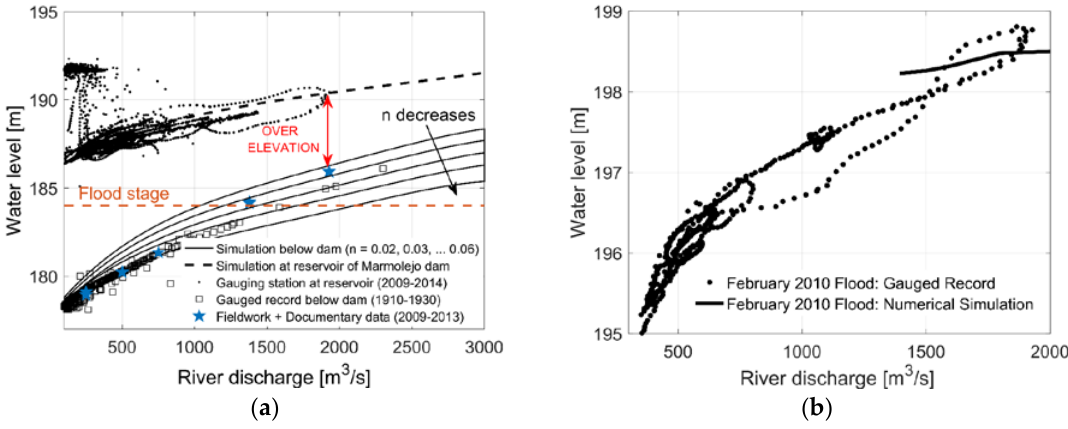
Figure 8. Measured and simulated rating curves at stream gauges: ( a ) reservoir and foot of Marmolejo dam; and ( b ) Roman Bridge of Andújar city. Panel ( a ) includes a sensitivity study of the dam; and ( b ) Roman Bridge of And ú jar city. Panel ( a ) includes a sensitivity study of the model results model results downstream of Marmolejo dam with variations in the Manning’s roughness downstream of Marmolejo dam with variations in the Manning’s roughness coefficient.